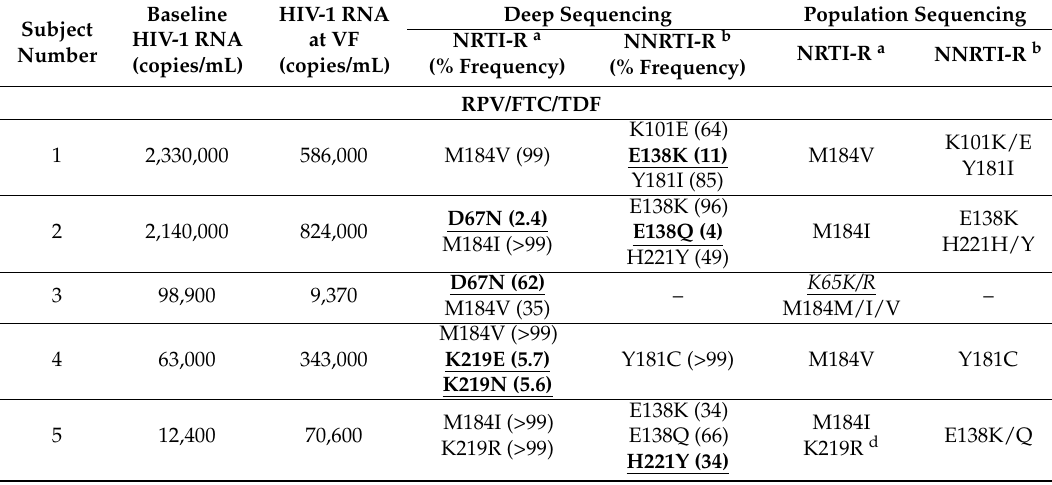
Table 4. Primary NRTI and NNRTI drug resistance mutations detected in virologic failure samples from RAP subjects by deep sequencing compared with population